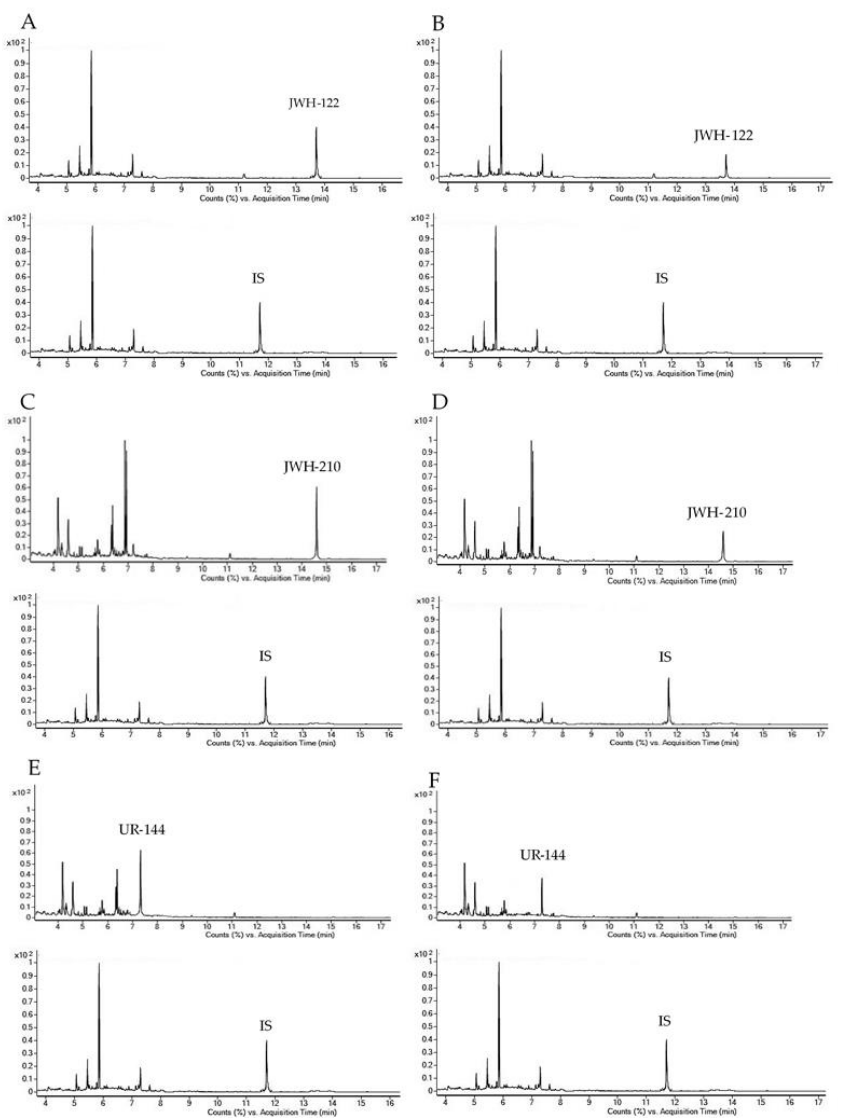
Figure 1. Gas chromatography-mass spectrometry (GC-MS) single ion monitoring chromatograms of 400 µL OF extract spiked with 1.00 ng/mL JWH-122 ( A ), JWH-210 ( C ) and UR-144 ( E ); OF samples of consumers containing 4.00 ng/mL JWH-122 ( B ); 8.10 ng/mL JWH-210 ( D ); 7.40 ng/mL UR-144 ( F ). IS, internal standard.